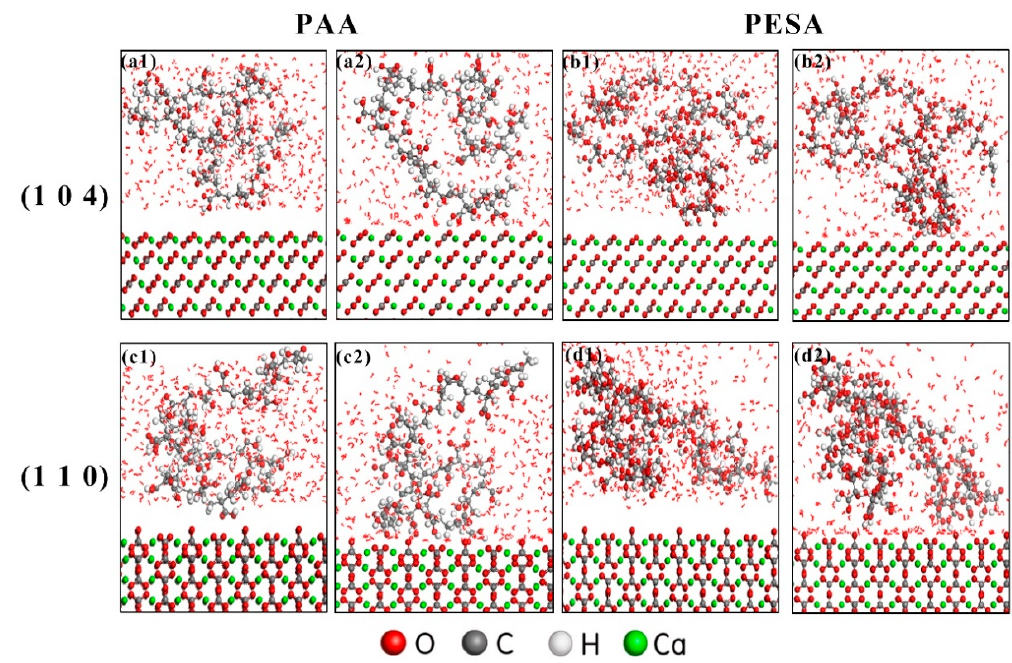
Figure 6. The initial configurations and the optimized results of the two inhibitors on the surfaces of the calcite. For PAA, ( a1 ) and ( c1 ) represent the starting configurations on the (1 0 4) and (1 1 0) faces, respectively, while ( a2 ) and ( c2 ) are the optimized simulation results correspondingly; for PESA, ( b1 ) and ( d1 ) display the starting configurations on the investigated faces and the homologous optimal simulation results are shown in ( b2 ) and ( d2 ). Table 1. The interaction energy (kcal / mol) of the two compounds with calcite (1 0 4) and (1 1 0)